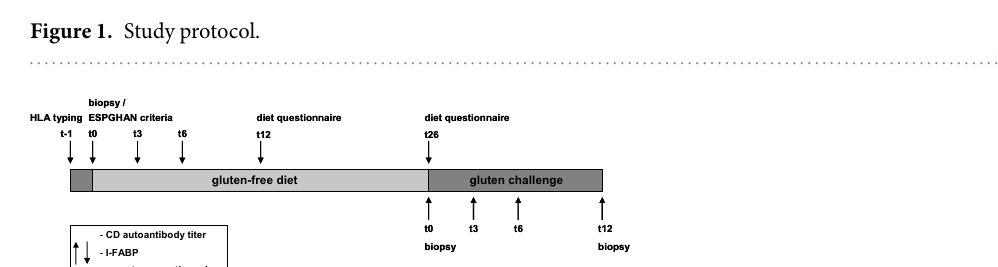
Figure 1. Study protocol.